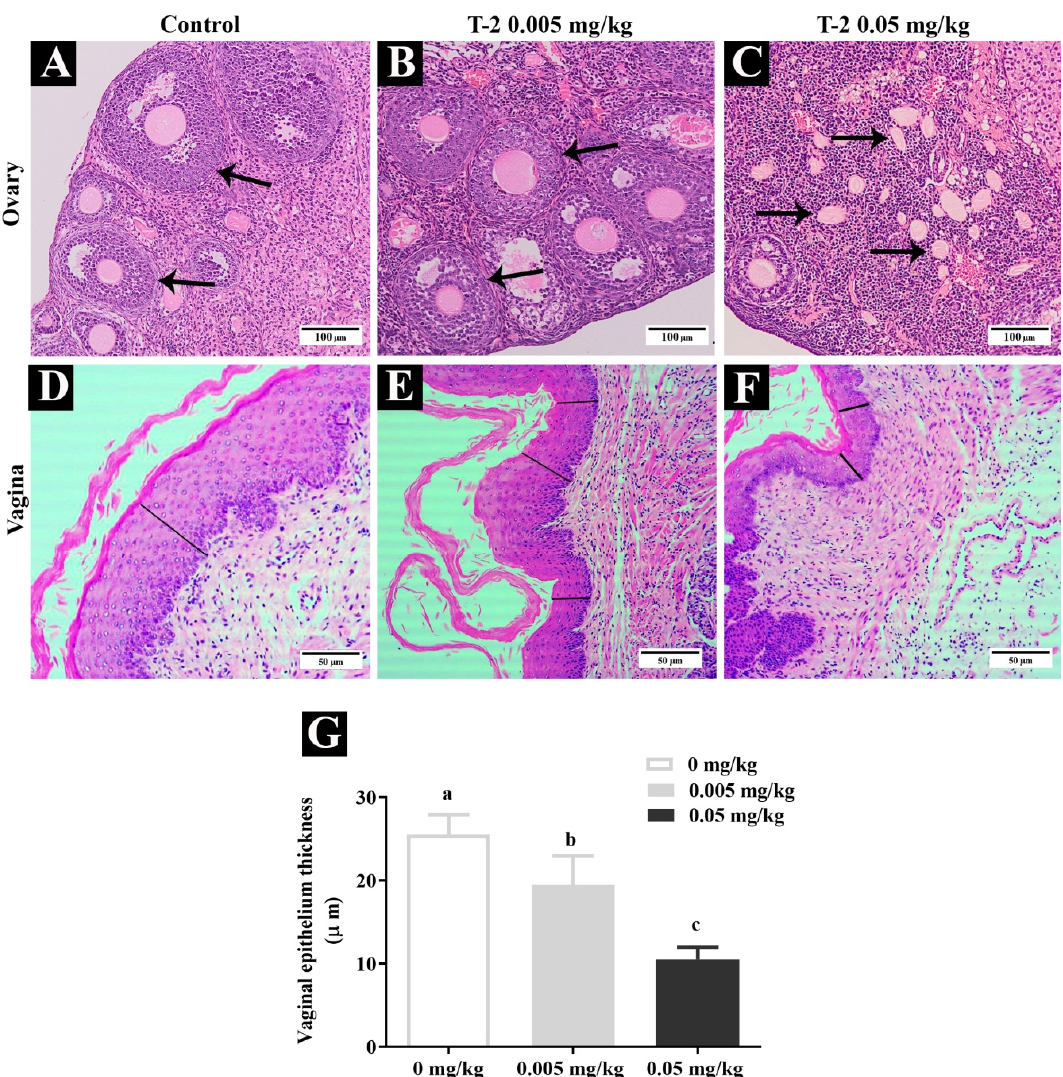
Figure 5. Representative pathological changes in ovaries: ( A ) control, ( B ) 0.005 mg/kg of T-2 toxin, ( C ) 0.05 mg/kg of T-2 toxin. The vaginal epithelium thickness: ( D ) control, ( E ) 0.005 mg/kg of T-2 toxin, ( F ) 0.05 mg/kg of T-2 toxin, and ( G ) measurement of vaginal epithelium thickness of mice offspring whose dams were orally administered with T-2 toxin at 0, 0.005, and 0.05 mg/kg from gestational day 14 (GD 14) to lactational day 21 (LD 21). Black arrows indicate the follicles are in secondary and antral stage in ( A , B ) and in ( C ) it indicates atretic follicles. Black lines in ( D , E , F ) indicate vaginal epithelium thickness. Scale bar: ovary 100 µm and vagina 50 µm.